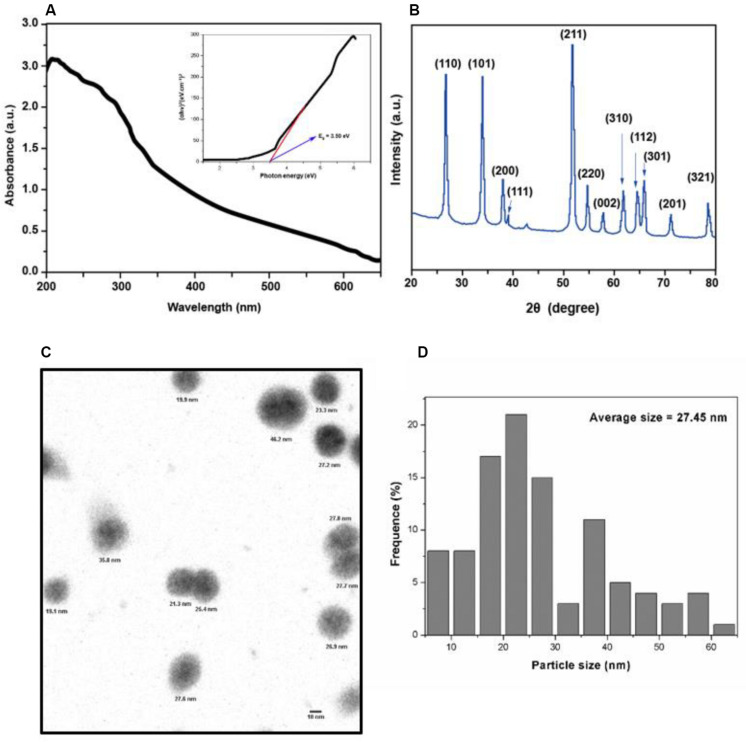
Characterization of SnO2 NP. (A) Absorption spectra of SnO2 NP. Figure inset represents the bandgap energy of SnO2 NP. (B) XRD spectra of SnO2 NP. (C,D) TEM micrograph of SnO2 NP and a histogram of the size distribution of SnO2 NP.